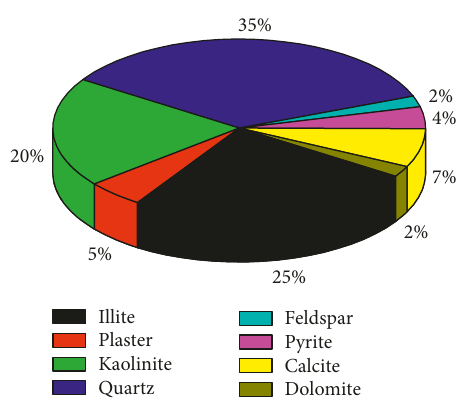
Figure 3: Mineral composition of carbonaceous